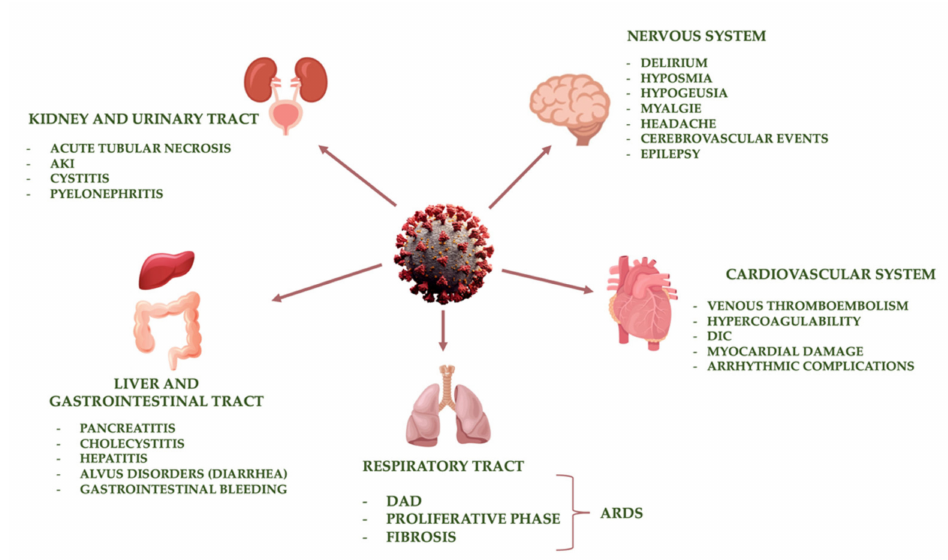
Figure 3. Main target organs of SARS-CoV-2 infection. Abbreviations: AKI, acute kidney injury; ARDS, acute respiratory distress syndrome; DAD, diffuse alveolar damage; DIC, disseminated intravascular